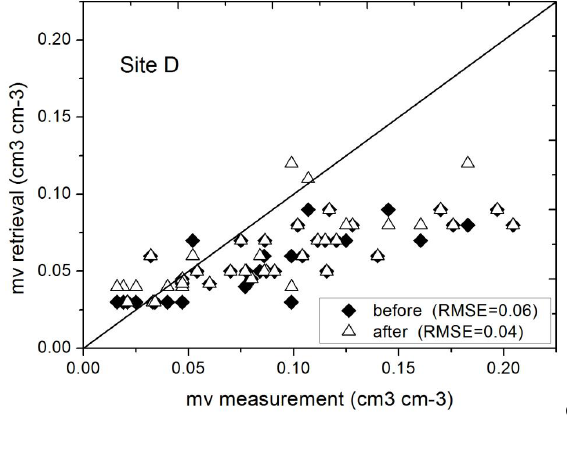
Fig. 6. Retrieved soil moisture based on the obtained surface rough- ness estimates. Figure 6. Retrieved soil moisture based on the obtained surface roughness estimates.